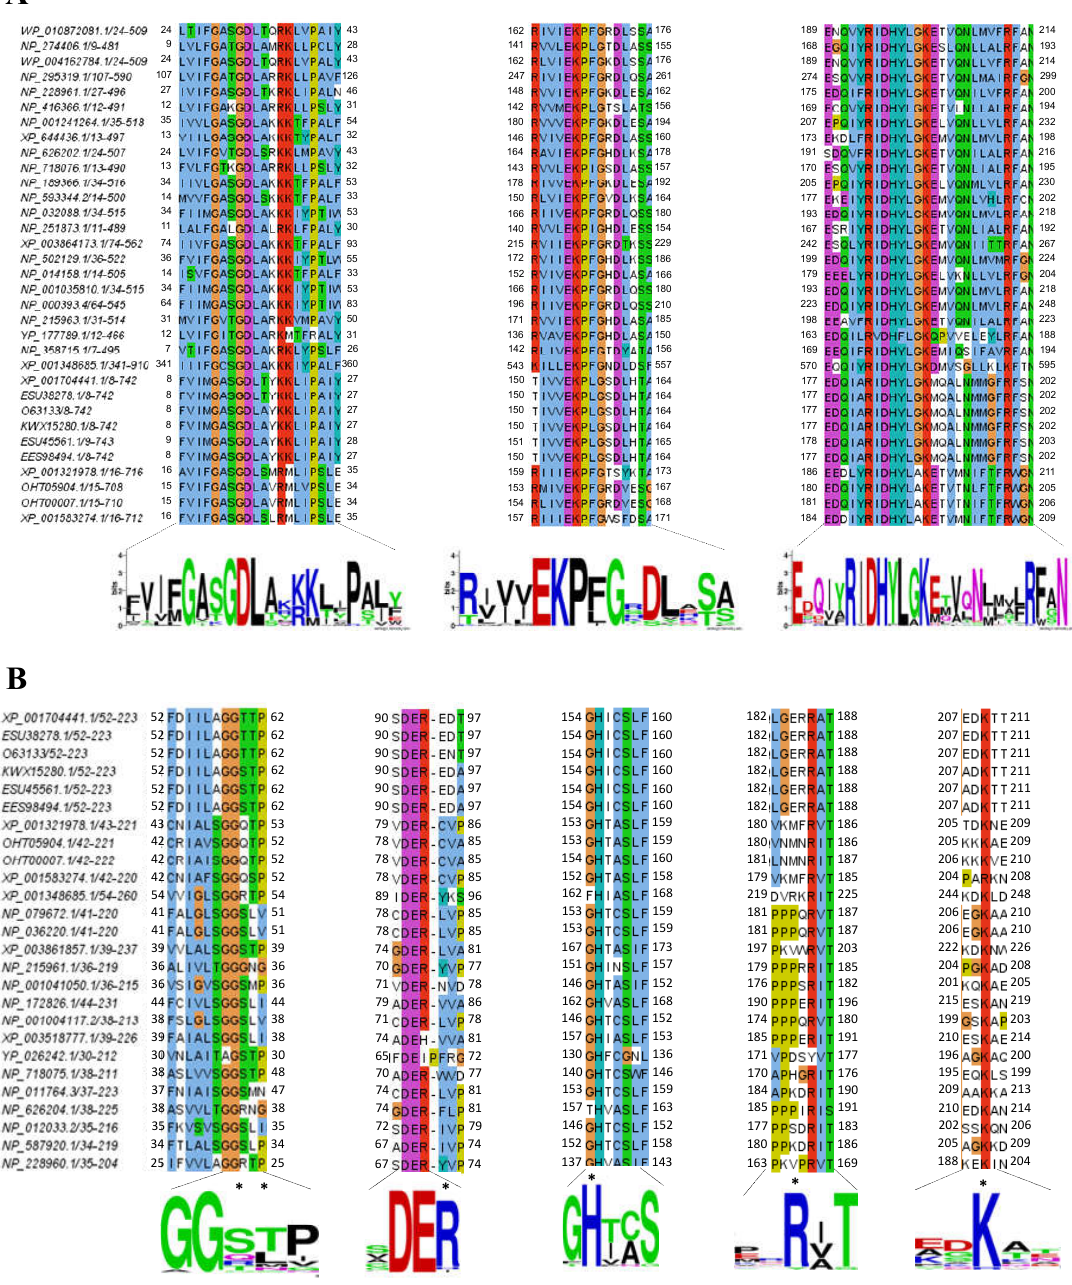
Figure 3. Multiple alignment of the amino acid sequences for the corresponding domain for the ( A ) G6PD and ( B ) 6PGL domain. Multiple sequence alignment was executed using the Model Organisms (landmark) sequences of the BlastP program with the online program ClustalW Content from MEGA7 (v. 7.0.21) software and the highly conserved amino acids were rendered with the WebLogo program. Three fully conserved regions are shown as colored boxes and asterisks for the G6PD. Asterisks ( ∗ ) indicate the amino acids conserved at the catalytic site from 6PGLs from other organisms. The taxonomic origin of the sequences used to identify the consensus sequences of G6PD and 6PGL are presented in Tables S1 and S2, respectively.